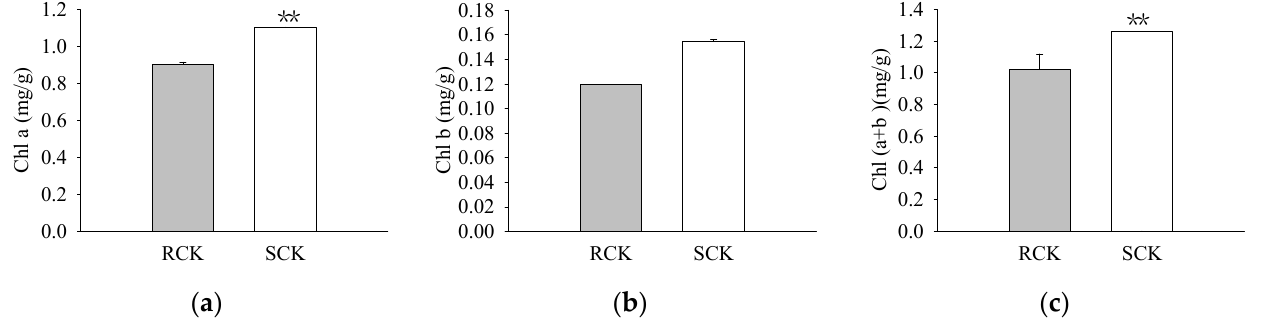
Figure 1. The chlorophyll (Chl) content of quinclorac-resistant (RCK) and -sensitive (SCK) E. crusgalli without quinclorac treatment. ( a ) Chl a content; ( b ) Chl b content; ( c ) Chl (a+b) content. * represents a statistically significant difference ( p < 0.05), and ** represents a statistically significant difference ( p < 0.01).